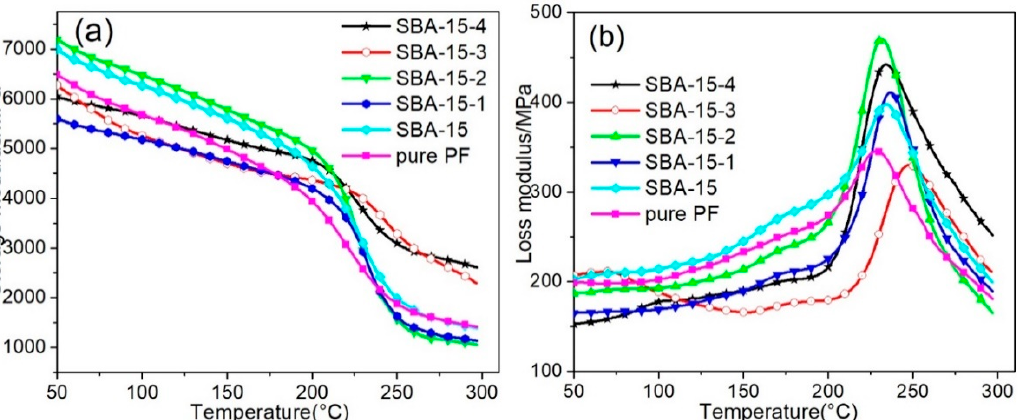
Figure 8. Temperature dependence of the storage modulus ( a ) and loss modulus ( b ) for the SBA-